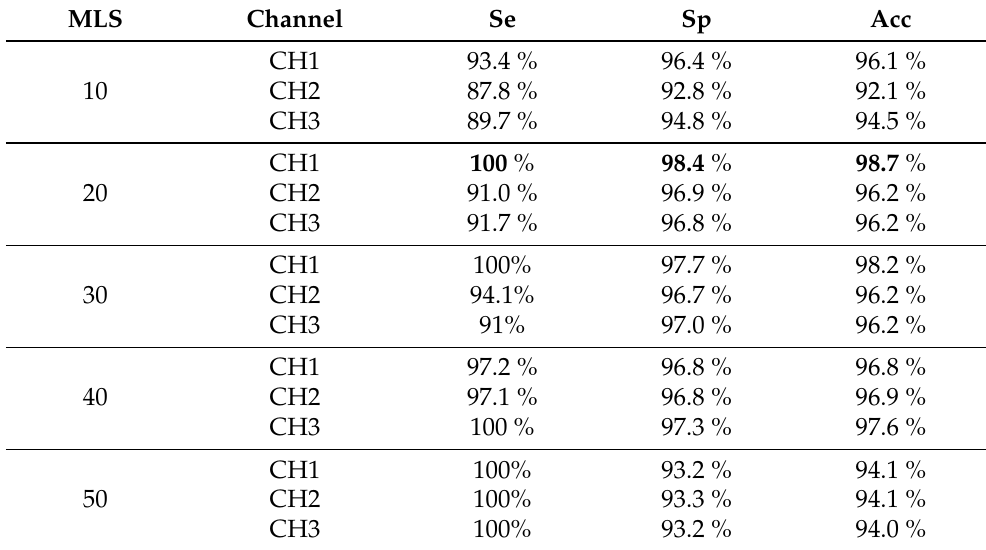
Table 3. Decision tree performance for different channel configurations. The best results are in bold.